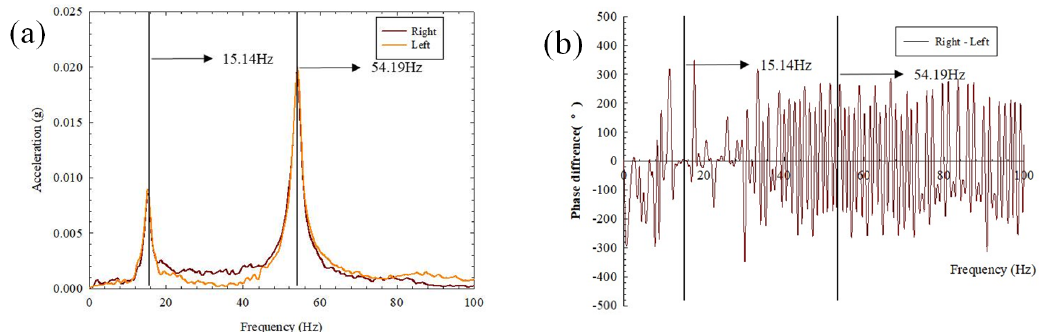
Figure 11. Results of the impact vibration load test in the bridge axis direction (outside). ( a ) Natural frequency of the third mode and ( b ) phase difference of the third mode. Table 2. Natural frequency results of the full-scale model pier according to the surcharge load.